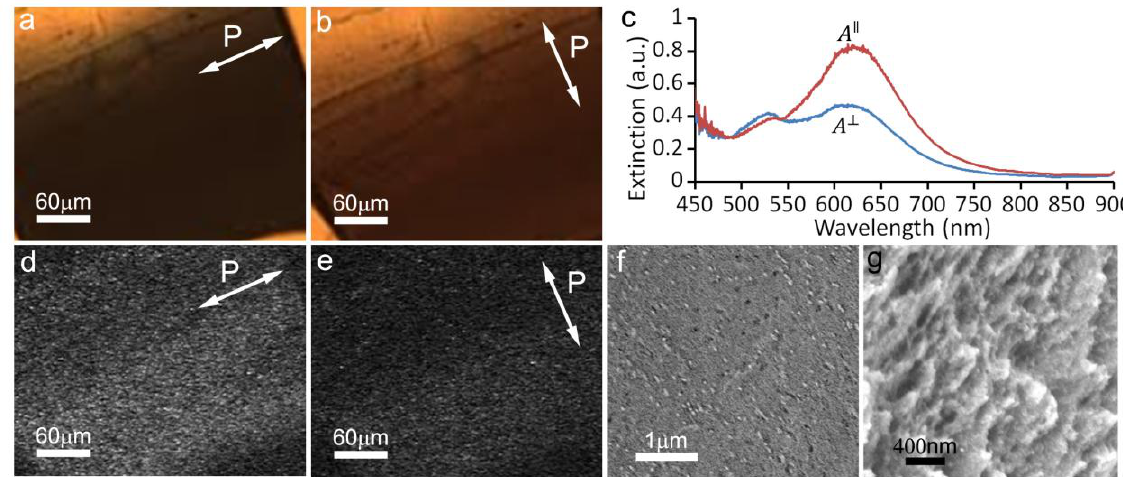
Figure 4. Mesoporous silica films containing aligned GNRs. ( a,b ) Bright field polarizing microscopy images with the polarization parallel ( a ) and perpendicular ( b ) to the director. ( c ) Absorption spectra of the film as measured with polarization parallel (red) and perpendicular (blue) to the director. ( d,e ) TPL images of GNRs taken with polarization parallel ( d ) and perpendicular ( e ) to the director, confirming alignment of the gold nanoparticles with their long axes on-average parallel to the director. The homogeneous TPL signal in the images confirms uniform distribution of GNRs. ( f,g ) SEM images of the mesoporous film showing ( f ) alignment of GNRs and ( g ) the porous morphology. To minimize charging, images ( f ) and ( g ) were acquired using ET at 1 kV and 2 kV primary beam acceleration voltage,